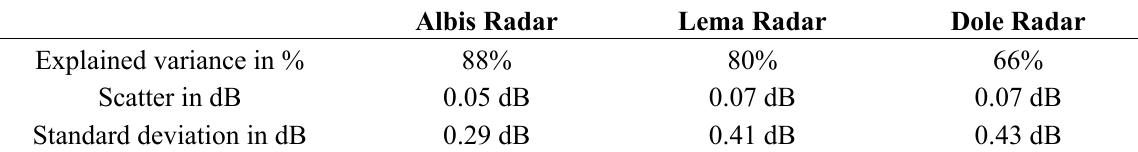
horizontal channel after having applied a three-day running median filter.